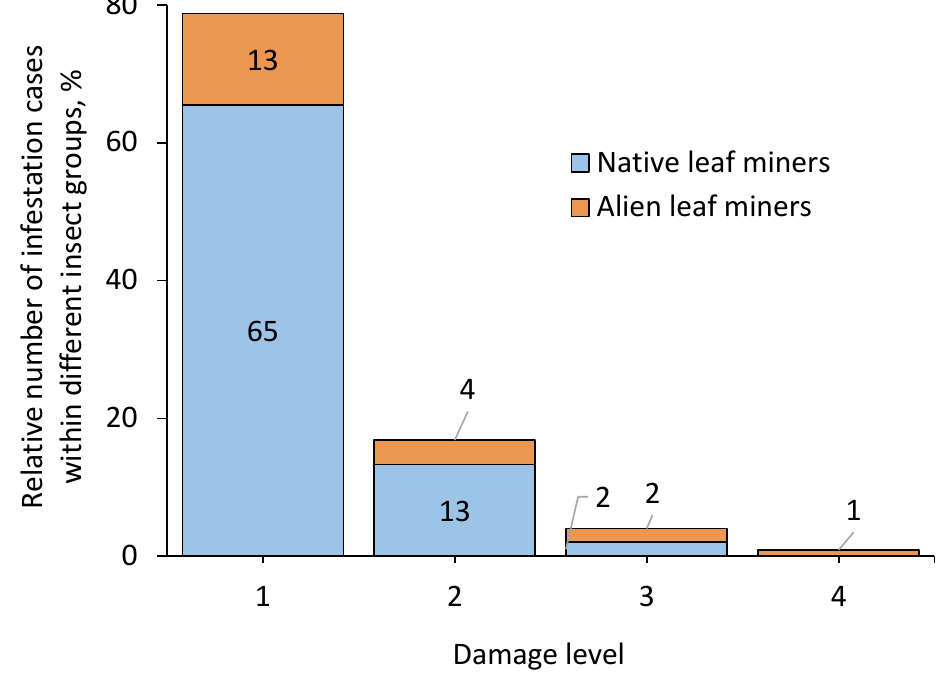
Figure 4. Relative number of infestation cases (%) among native and alien leaf-mining insects based on damage level: low (1%–24% of leaves with mines per 100 leaves), 2—medium (25%–49%), 3—high (50%–75%), and 4—severe (>75%).